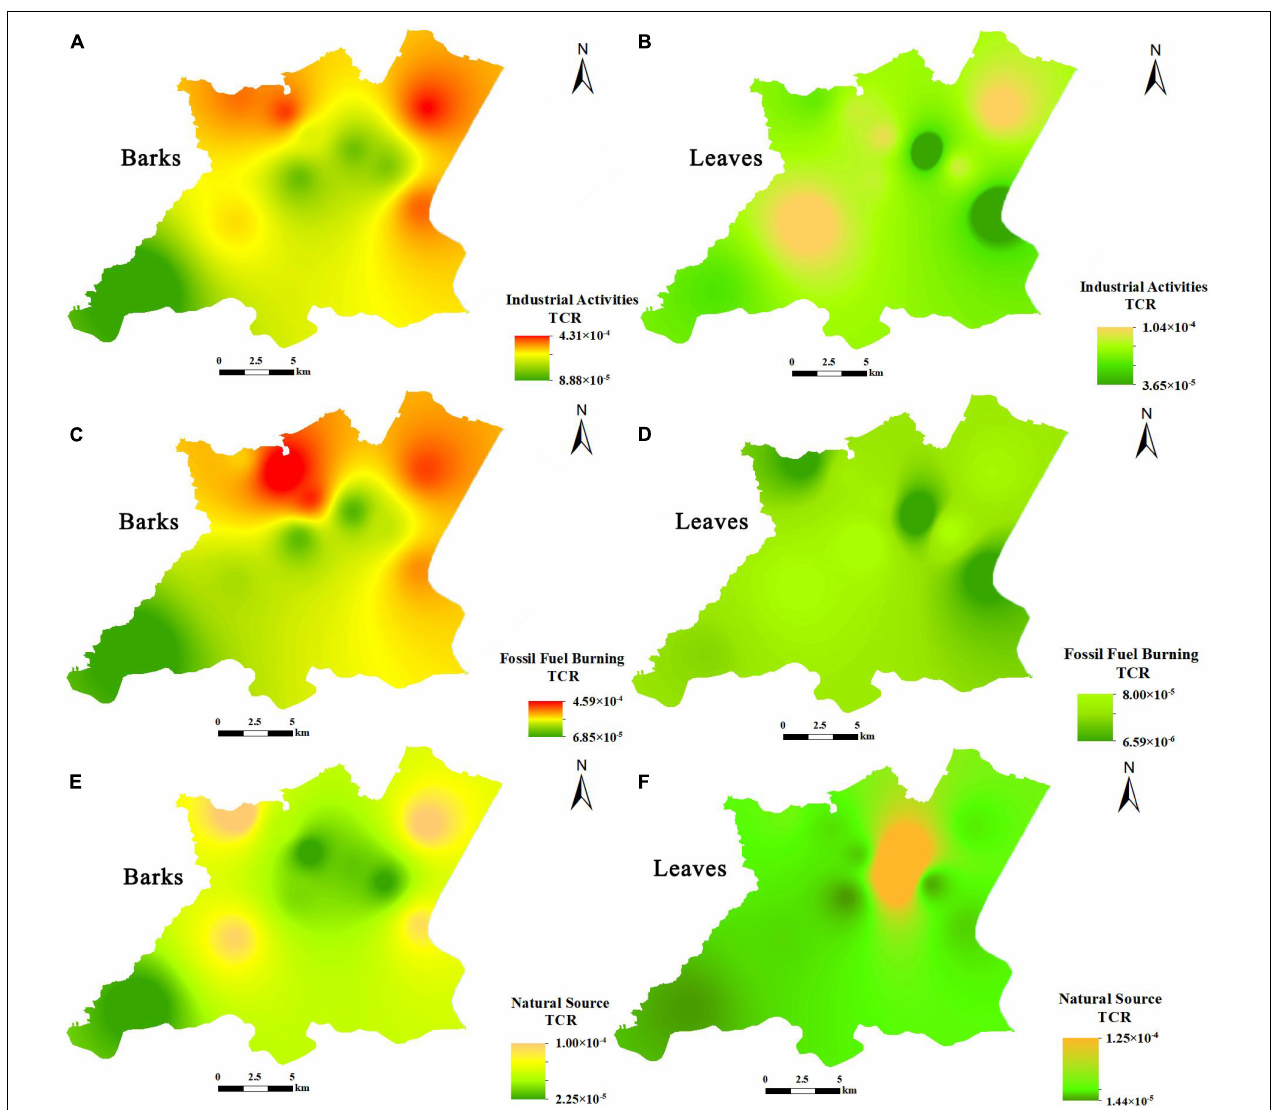
FIGURE 5 | Effects of pollution sources on the carcinogenic risk of camphor barks and